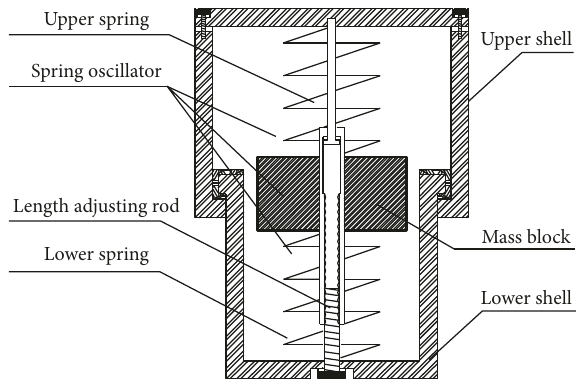
Figure 2: Schematic of the wave